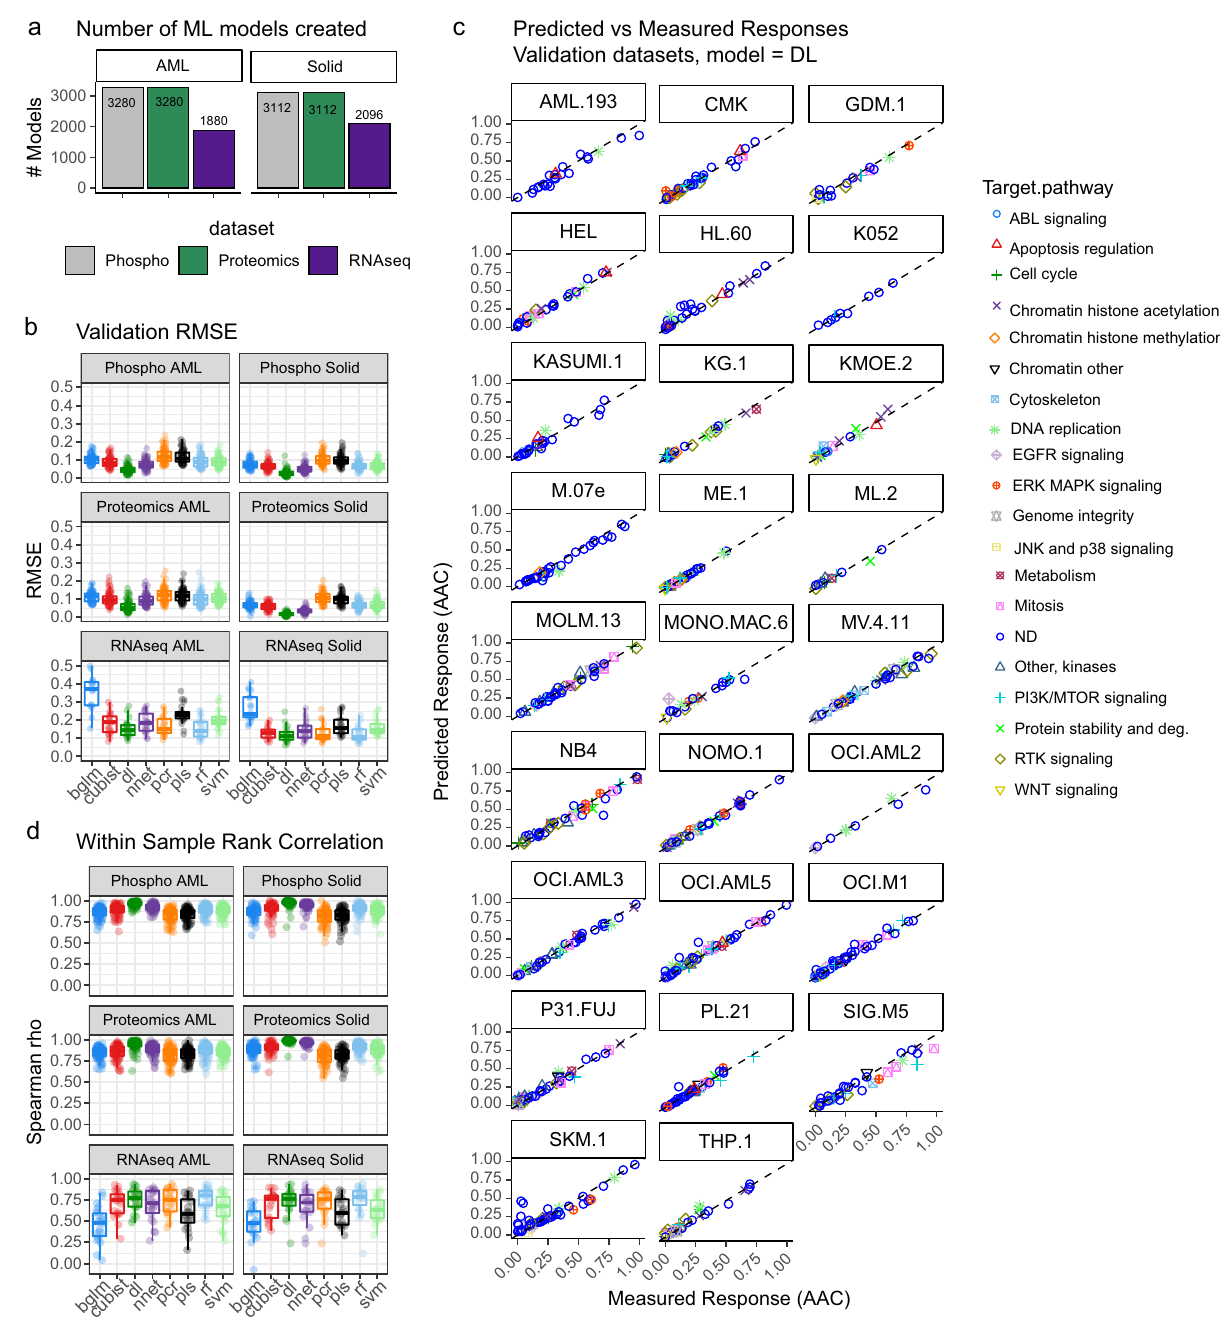
Fig. 4 Performance and accuracy of DRUML to rank drugs based on ef fi cacy. a Total number of models generated from phosphoproteomics, proteomics and RNA-seq data. Input data were split into solid ( n = 22) and AML ( n = 26) cell line groups for model building. b Validation errors for each model generated binned by ML method and input dataset. c Comparison between measured and predicted drug response values produced by DL analysis of phosphoproteomics distance values in the AML datasets. Each data-point represents a drug prediction color coded by the drugs ’ mode of action. Each cell line was analyzed in triplicate and representative comparisons are shown. Dotted line denotes slope of 1 with 0 intercept. d Spearman rank correlation coef fi cient rho values between predicted and actual responses returned by the different learning models and input datasets). Boxplots ( b and d ) have median centers, upper and lower quartile box boundaries and range upper and lower hinges. Learning algorithms were random forest (rf), cubist, bayesian estimation of generalized linear models (bglm), partial least squares (pls), principal component regression (pcr), support vector machine (svm), deep learning (dl) and neural network